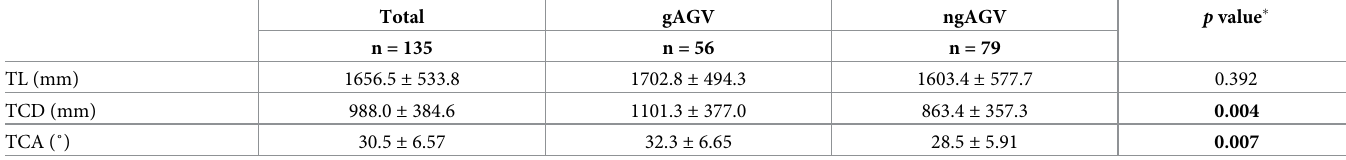
Table 4. Comparison of tube parameters between the guided and non-guided Ahmed glaucoma valve implantation groups.